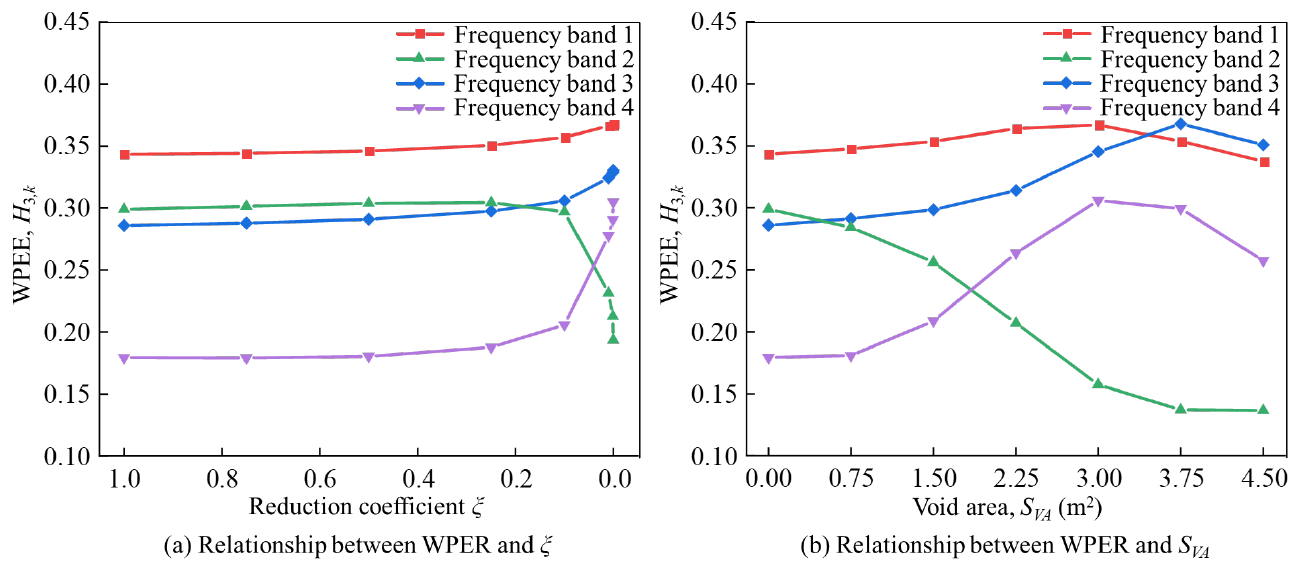
Figure 17. The change in the WPEEs of frequency bands 1 – 4 of the signal at monitor point 3.